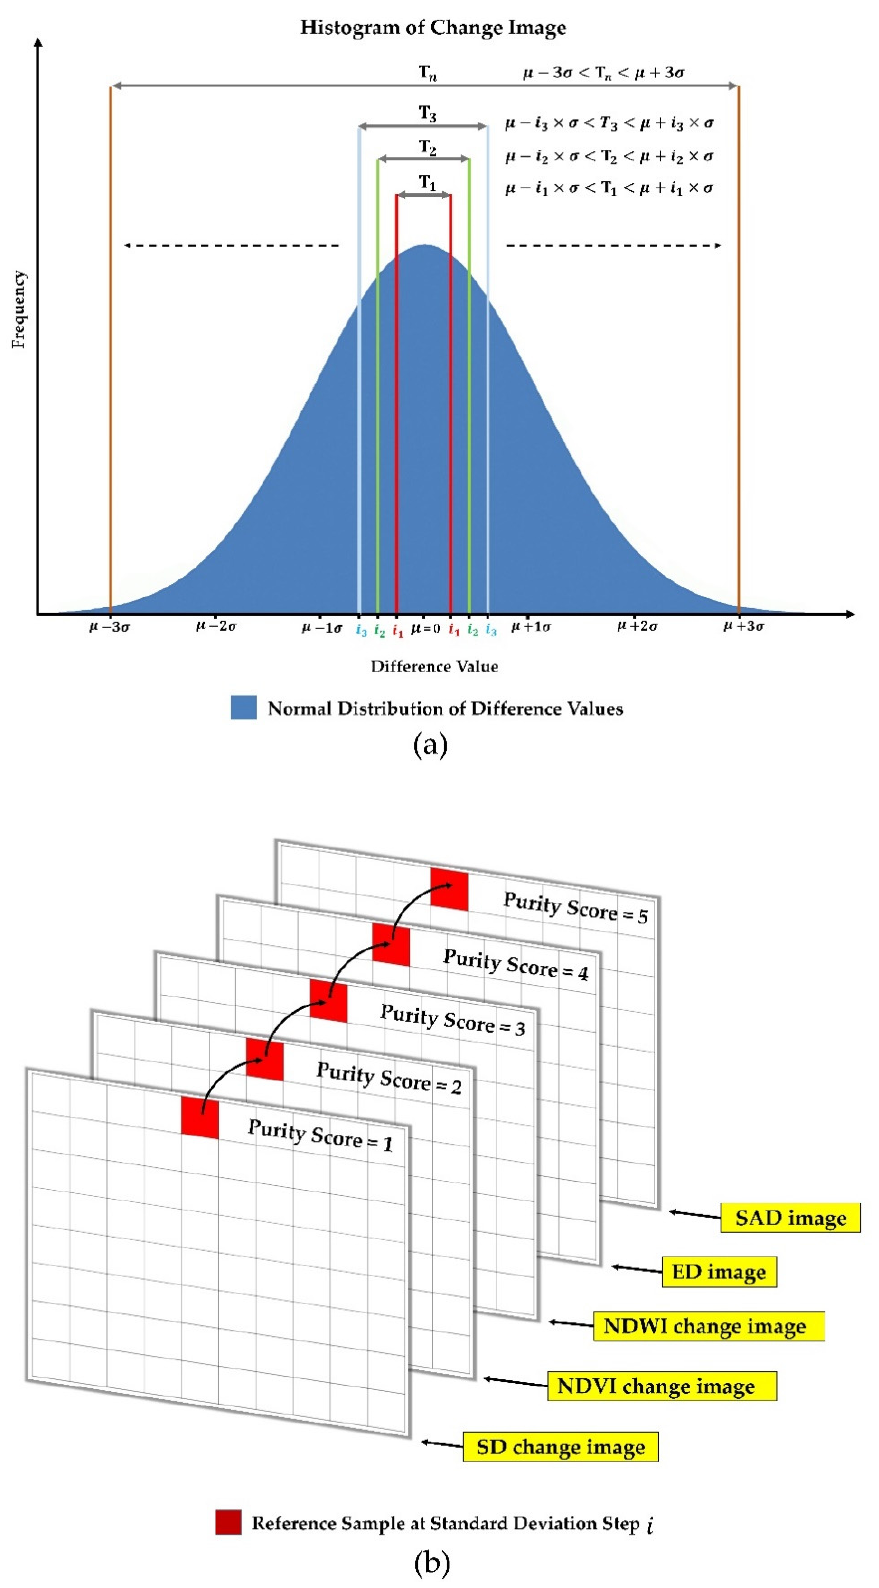
Figure 4. The workflow of the optimum threshold determination. ( a ) The histogram thresholding using stepwise values of the SD. ( b ) The selection of the samples with the highest purity score (i.e., the most likely unchanged samples).